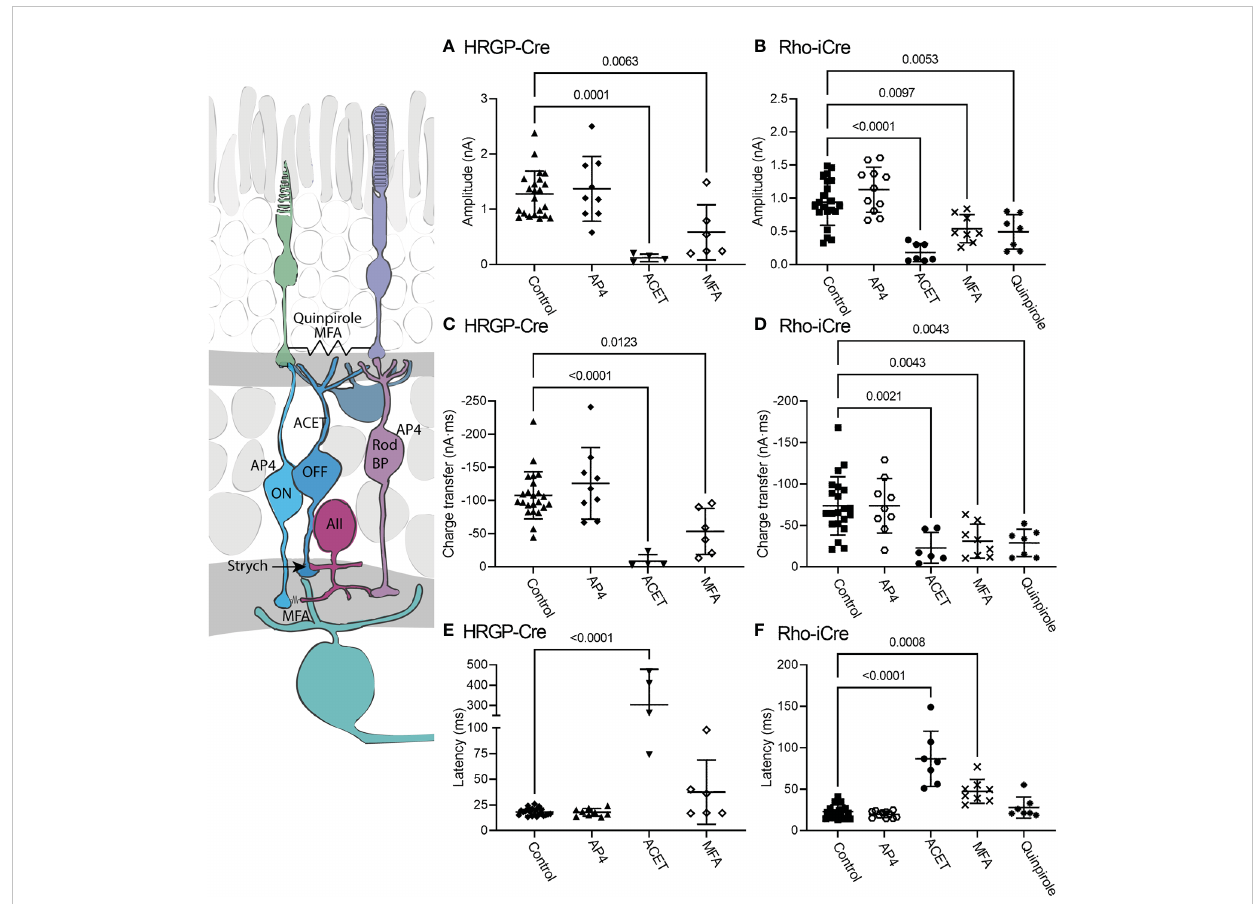
FIGURE 5 Pharmacological analysis of rod inputs to OFF a RGCs. At the left is a diagram illustrating the sites targeted pharmacologically. L-AP4 saturates mGluR6 glutamate receptors in rod and ON cone bipolar cells. ACET inhibits KA receptors in cone OFF bipolar cells. MFA targets rod-cone gap junctions and gap junctions between AII amacrine cells and ON cone bipolar cells. The D2/D4 dopamine receptor agonist quinpirole also reduces gap junctional coupling between rods and cones. Strychnine was present throughout these experiments to block the glycinergic synapse from AII amacrine cells to OFF cone bipolar cells that convey signals from rod bipolar cells into the OFF pathway. (A) Responses evoked by optogenetic stimulation of cones were reduced signi fi cantly by blocking KA receptors with ACET (10 m M, n=4 cells, 3 mice) or by using the gap junction blocker, MFA (100 m M, n=6 cells, 6 mice). (HRGP-Cre control, n=22 cells, 8 mice; HRGP-Cre AP4, n=9 cells, 3 mice) (B) Responses evoked by optogenetic stimulation of rods were reduced signi fi cantly by blocking KA receptors with ACET (10 m M, n=8 cells, 3 mice), the gap junction blocker, MFA (100 m M, n=8 cells, 8 mice), and the D2/D4 dopamine receptor agonist quinpirole (1-3 m M, n=7 cells, 7 mice). (Rho-iCre control, n=21; Rho-iCre AP4, n=9 cells, 6 mice). (C) Cone-driven response charge transfer was also signi fi cantly reduced by ACET and MFA. (D) Rod-driven response